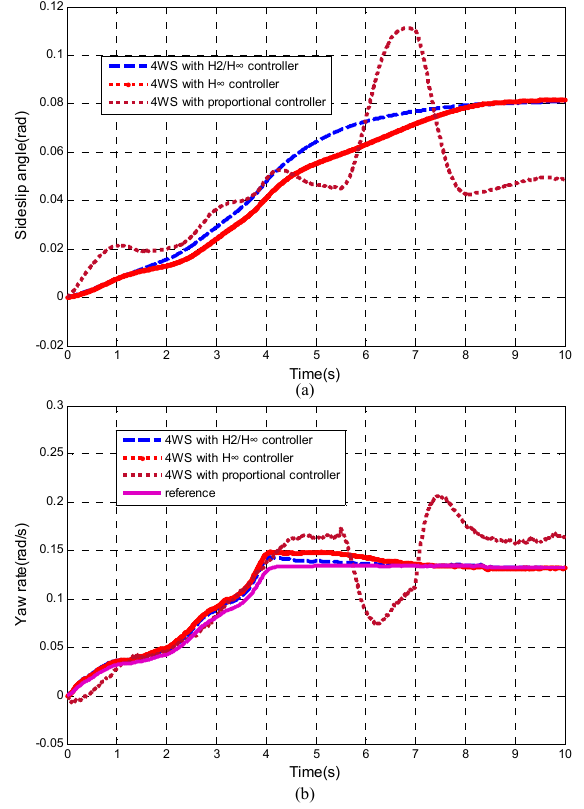
Figure 32. Experimental results: ( a ) sideslip angle; ( b ) yaw rate.